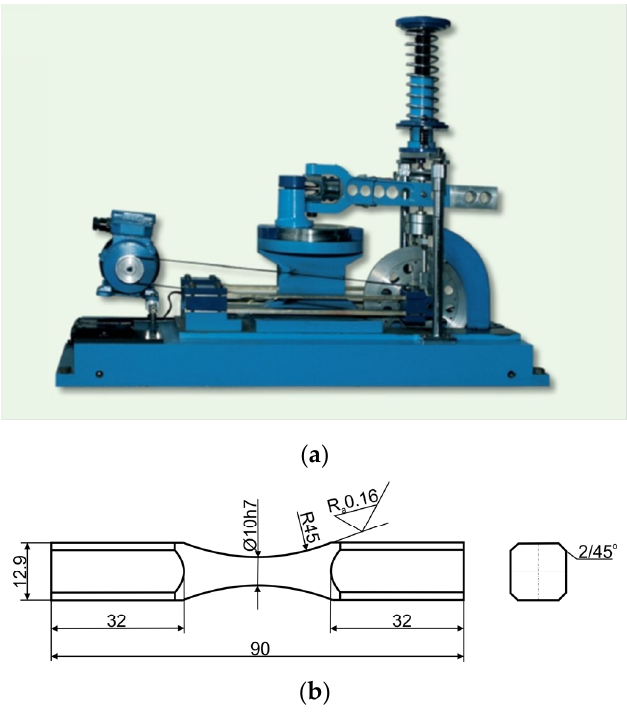
Figure 2. ( a ) Test stand MZGS-100 and ( b ) specimen for fatigue strength tests.